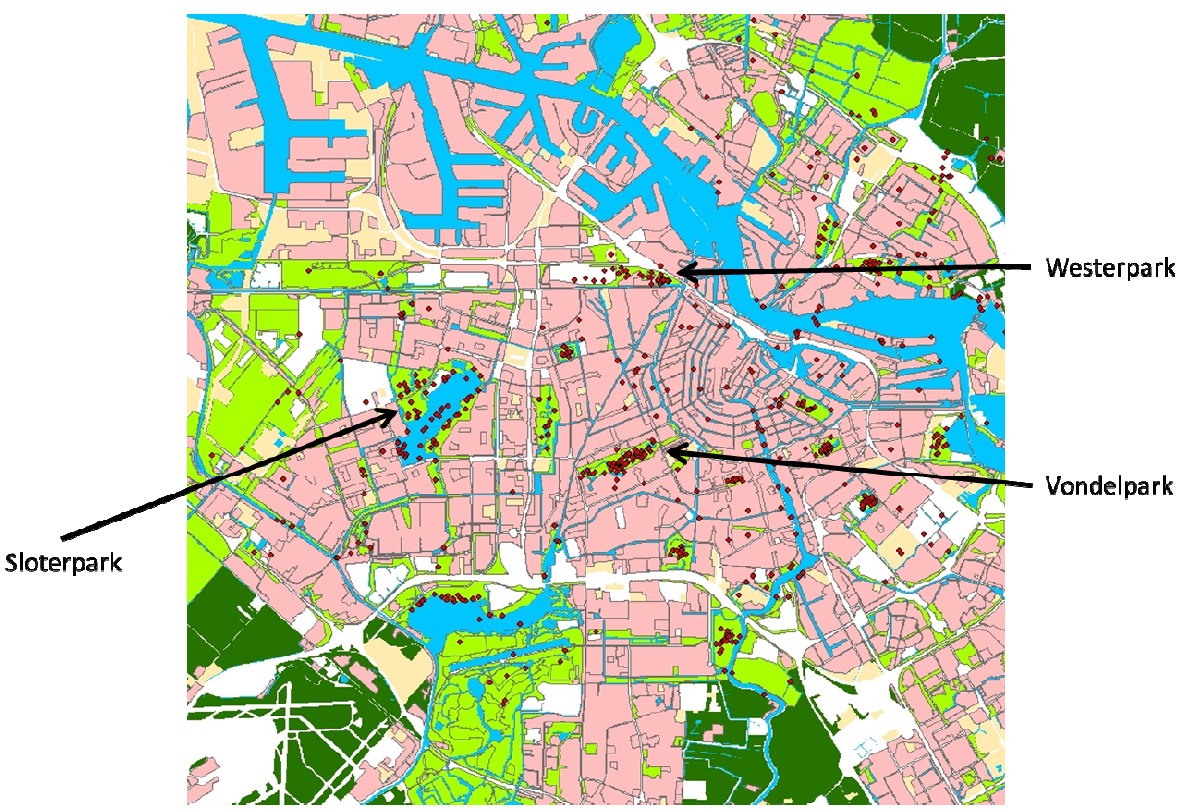
Figure 3. The city of Amsterdam with markers indicating the local favourite natural places of Amsterdam residents (n =